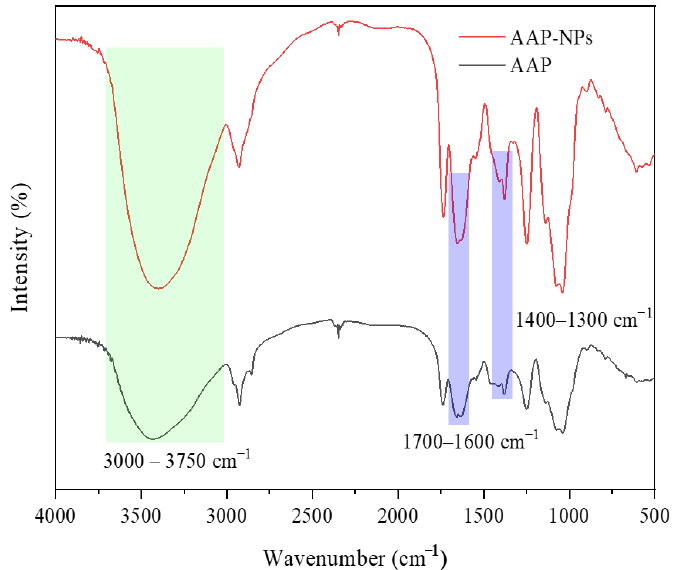
Figure 5. FTIR images of AAP-NPs prepared at the optimal conditions and those of the original AAP.